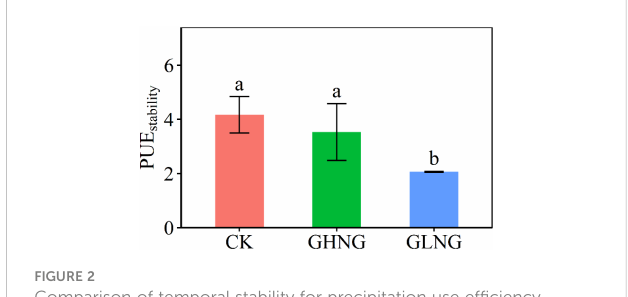
FIGURE 2 Comparison of temporal stability for precipitation use ef fi ciency (PUE stability ) in 2015 – 2019 among the control (CK), warming level of growing-season higher than warming level of non-growing-season treatment (GHNG) and warming level of growing-season lower than warming level of non-growing-season treatment (GLNG). Different letters indicate signi fi cant differences among the three treatments at p <0.05